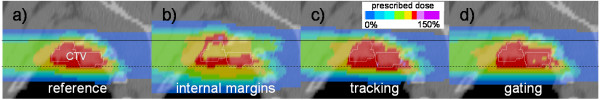
4D treatment planning for a lung tumor. Dose distributions (color-wash) on the reference 4DCT phase (grey-levels, CTV contour in white) for different motion mitigation techniques in comparison to (a) the dose distribution for a stationary target. (b) Internal margins can not properly mitigate target motion. Interplay between beam scanning and organ motion leads to a deteriorated dose distribution. Tracking (c) and gating (d) allow appropriate mitigation of target motion. Resulting dose distributions cover the CTV comparable to (a). Motion parameters: respiratory period 2 s, initial respiratory phase 90°, Lujan model (n = 2), synchrotron extraction modeled for HIT.